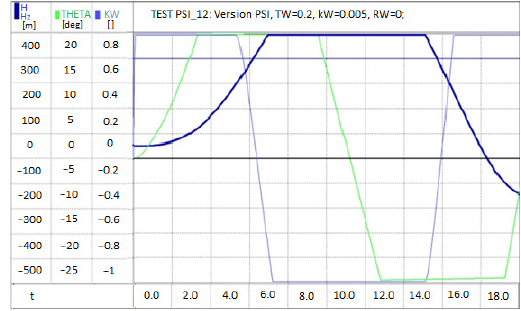
Figure 4. The transitional process of controlling flight altitude ( H ), by making step changes to the given flight value from 50 metres to 400 metres, for the derivative constant of k w = 0.005 and R w. = 0